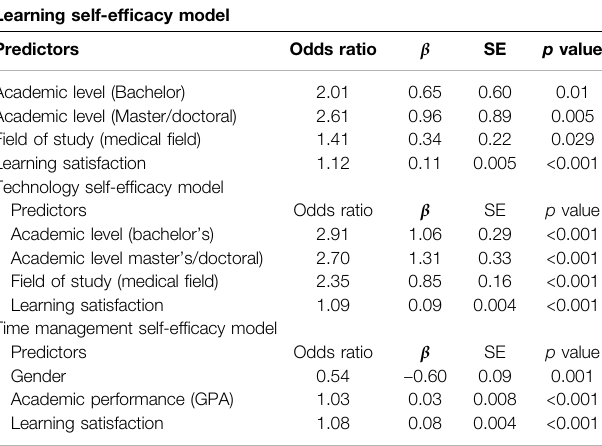
TABLE 5 | Ordered logistic regression predicting the domains of self-ef fi cacy ( n (cid:1) 892). Learning self-ef fi cacy model